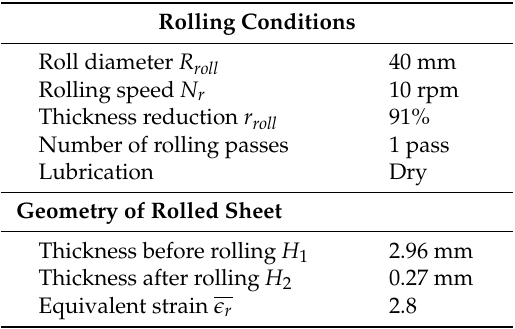
Table 2. Rolling conditions and geometry of the rolled